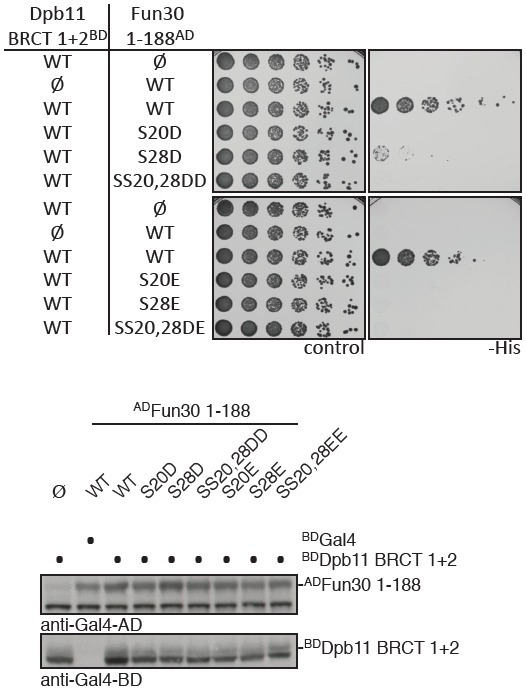
Phospho-mimetic mutants of Fun30 S20 and S28 disrupt the interaction with Dpb11.(a) Two-hybrid spotting of strains expressing phospho-mimetic versions of ADFun30 1-188 (S20D, S28D, SS20,28DD, S20E, S28E and SS20,28EE respectively) and BDDpb11-N. Cells were grown for three days at 30°C. (b) Two-hybrid constructs are detected with anti-Gal4-AD (AD-Fun30 1-188) and with anti-Gal4-BD (for BD-Dpb11-N) antibodies.